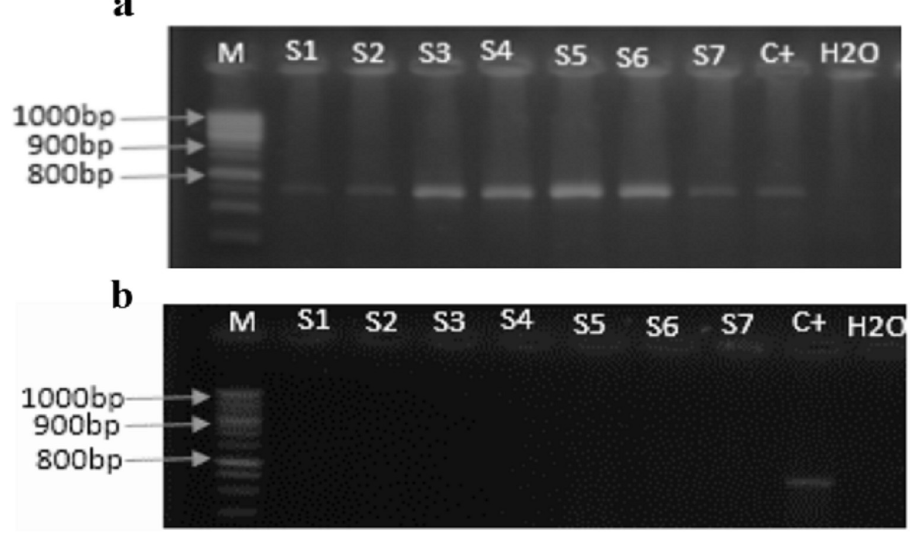
Fig 4. Electrophoresis gels showing CMD virus in inoculum source plants. Amplification of coat protein sequence of ACMV ( a ) and EACMV ( b ). M: ladder (1000 bp– 100 bp); S1 –S7: leaf sample tested; C + : positive control; H20: grade water used as negative